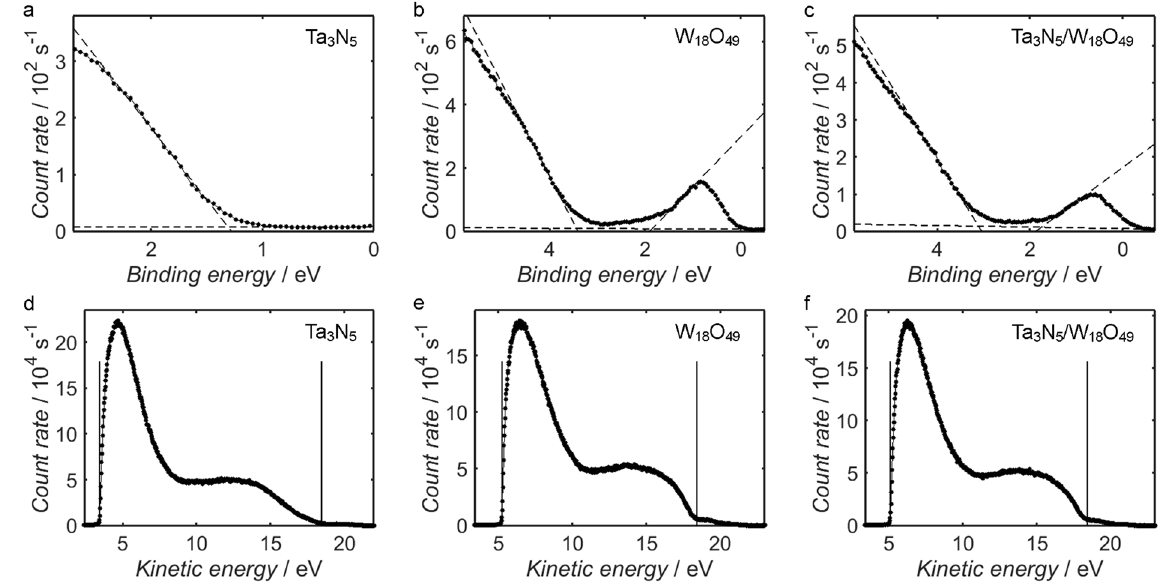
Figure 5. XPS measurements of the valence band edge of Ta 3 N 5 ( a ), W 18 O 49 ( b ) and Ta 3 N 5 /W 18 O 49 ( c ), and UPS measurements corresponding to the same materials ( d – f ). Linear fits to the valence band edge and the baseline are depicted as dashed lines in ( a – c ), the intersection of which may be interpreted as the energy of the valence band maximum, E V , relative to the Fermi level, E F . In ( b , c ), a similar procedure has been carried out to calculate the position of the conduction band minimum, E C . The estimated positions of E V and the secondary electron onset, E SEO , from UPS are shown in plots ( d – f ) as solid vertical